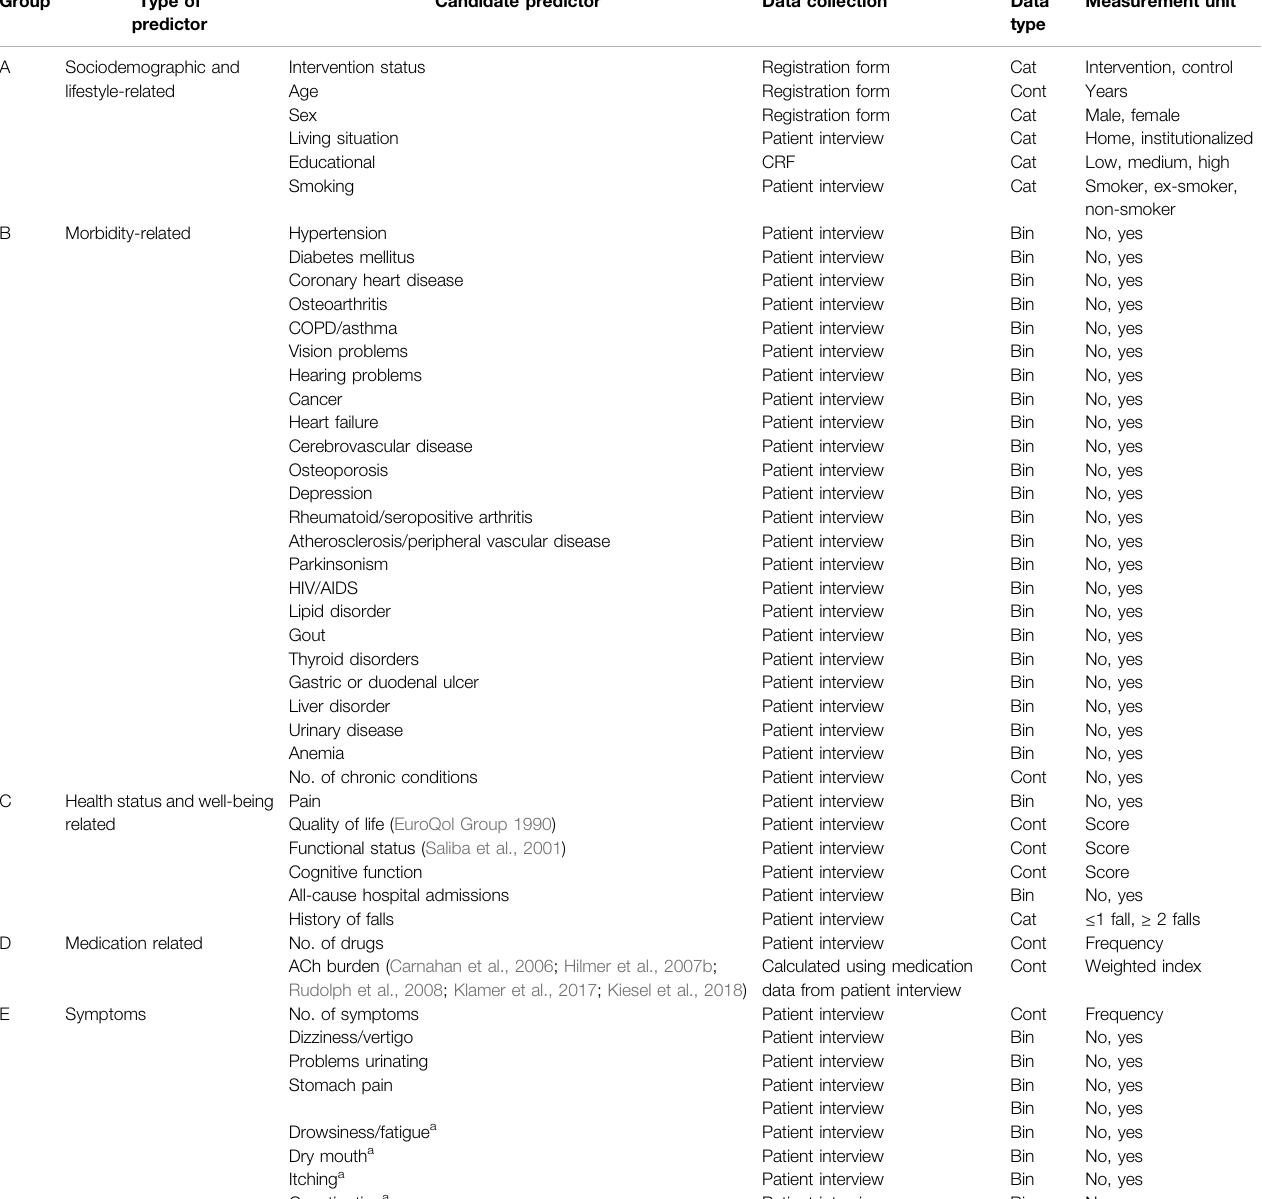
TABLE 2 | Candidate predictors available in the development dataset.